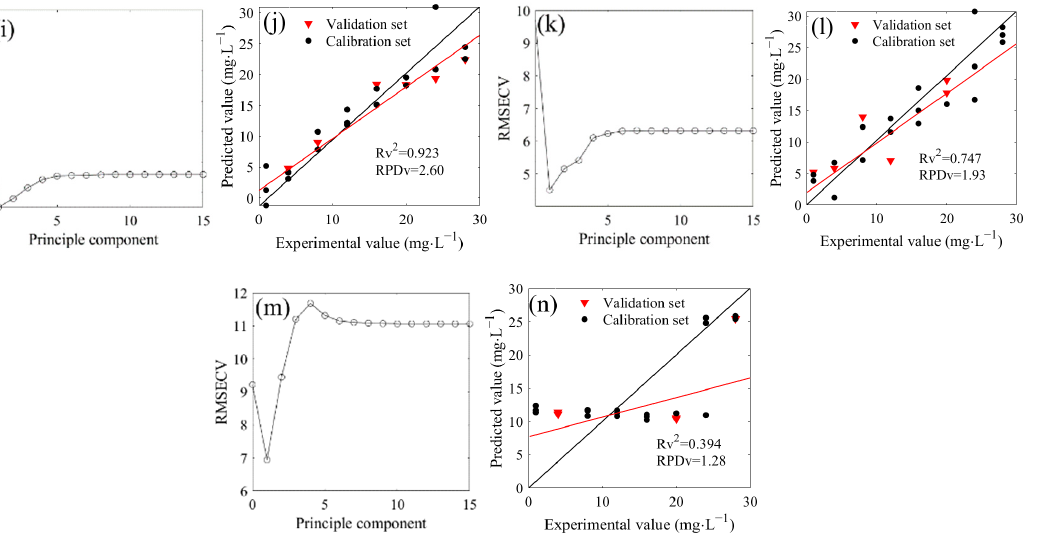
Figure 4. Distribution and model evaluation of the partial least squares regression (PLSR) principle component ( a , c , e , g ,i, k , m ), training set (n = 18), and testing set (( b , d , b , h , j , l , n ); n = 6) of the PLSR prediction model based on FTIR-ATR spectra (with water deduction algorithm) of of 14 NO 3 − and 15 NO 3 − mixtures with different proportions ( 4 N/ 15 N, 1:0 ( a , b ); 3:1 ( c , d ); 2:1 ( e , f ); 1:1 ( g , h ); 1:2 ( i , j ); 1:3 ( k , l ); 0:1 ( m , n )). A bias value close to zero indicates a low systematic error between the measured and predicted values. The biases of the models were shown in Table 1. According to the absolute value, the low systematic errors of seven models were 0.302, 0.232, 0.192, 0.269, 0.163, 0.156, and 0.298, respectively. Table 1. Statistics of the PLSR models used in the calibration and validation sets for the prediction of f 14 NO 3 − and 15 NO 3 − in the mixtures with different proportions using FTIR-ATR spectra (with water deduction